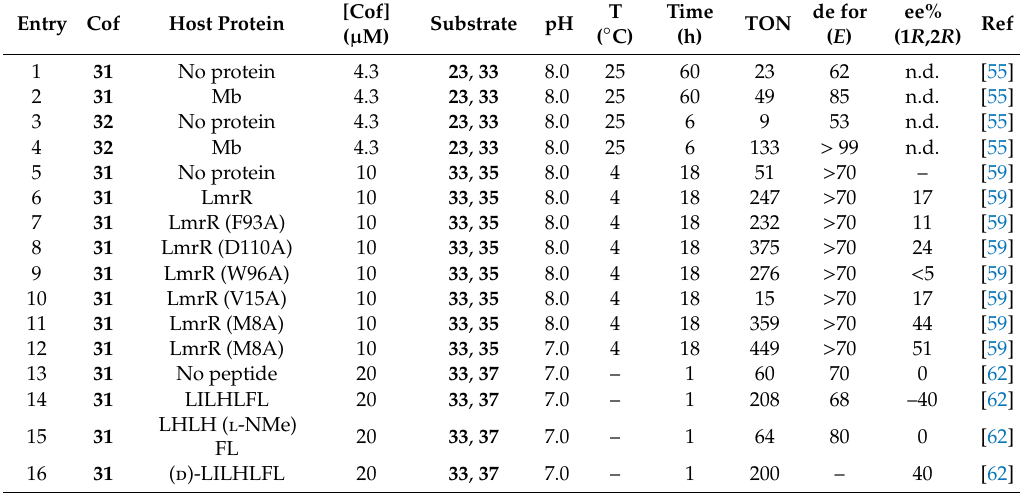
Table 3. Selected results of cyclopropanation catalyzed by ArMs containing iron porphyrinoids as their cofactor